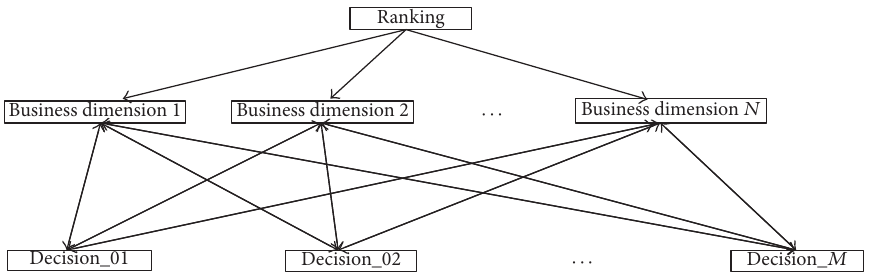
Figure 4: Ranking of preferences. Source: the